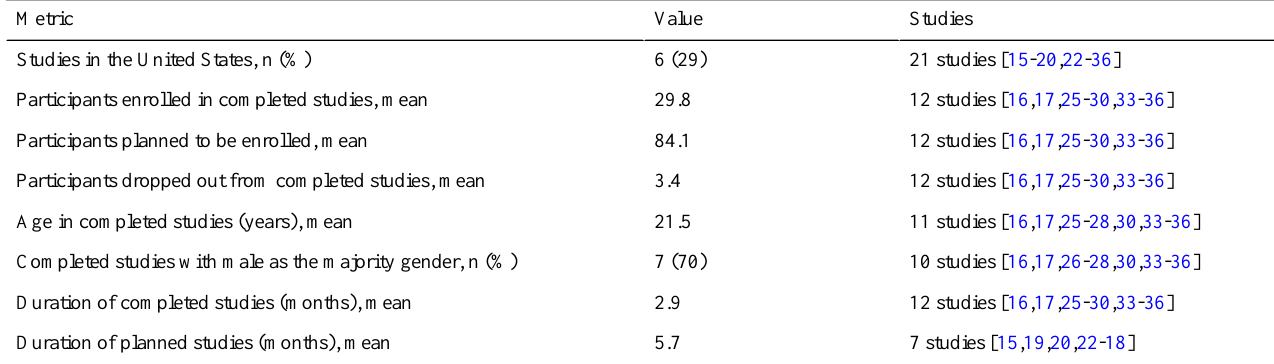
Table 2. Summary metrics for studies on smartphone apps for people with first-episode psychosis or at clinical high risk.